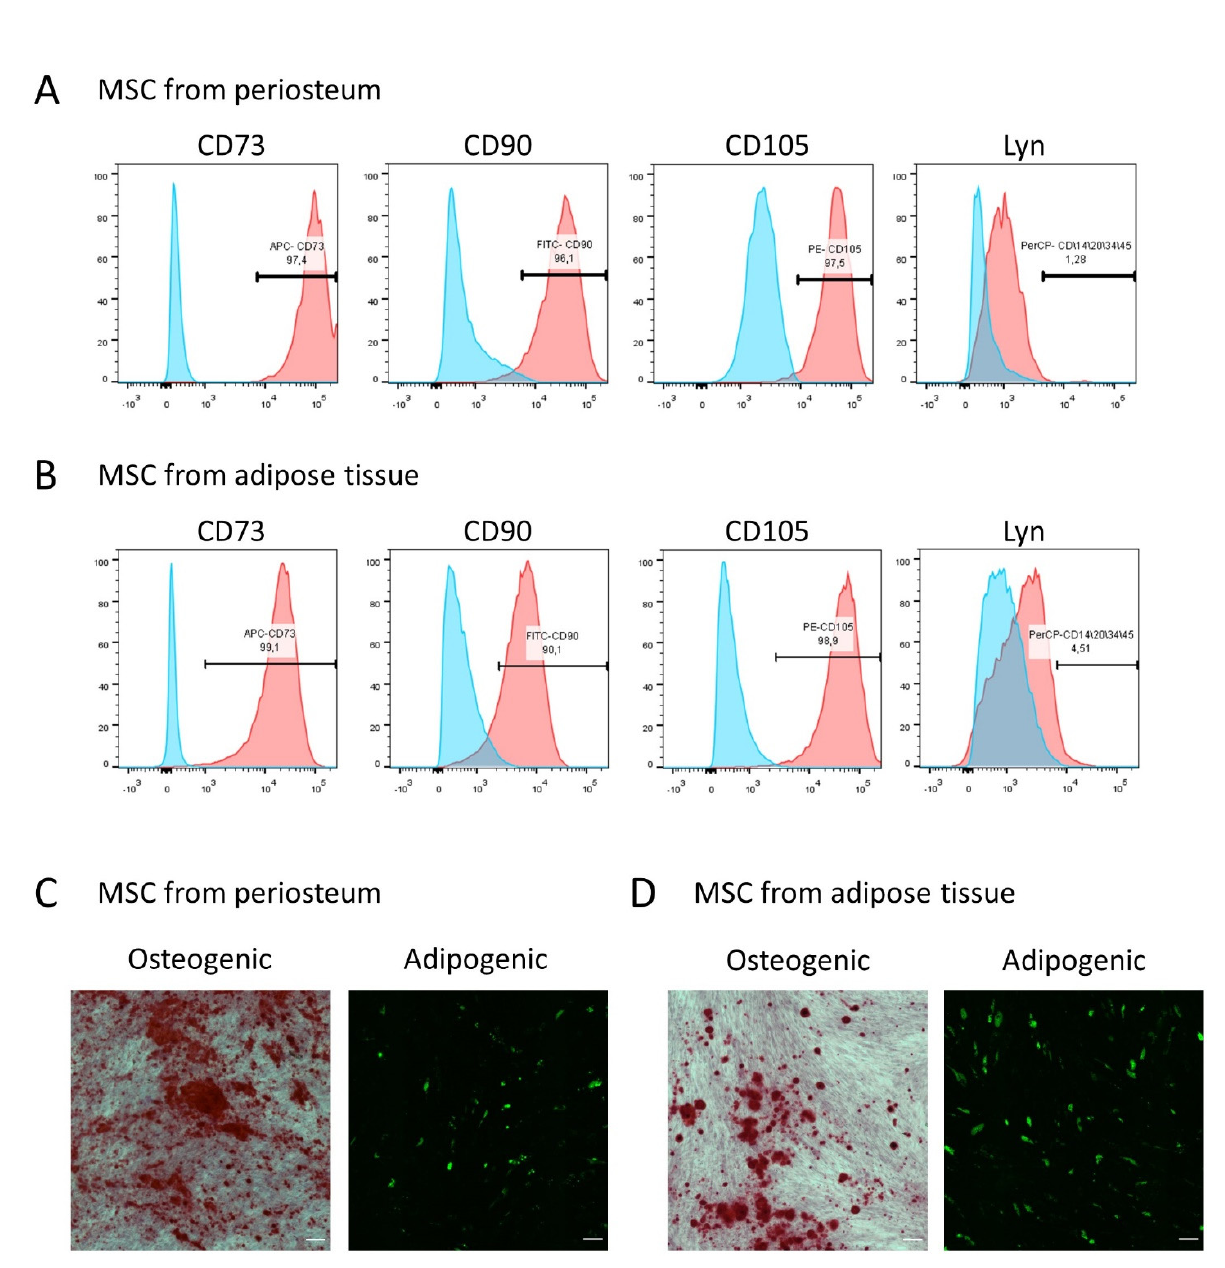
Figure 1. Characterization of MSC isolated from periosteum and adipose tissue. ( A , B ) Flow cytometry analysis of expression of positive surface markers CD73, CD90, and CD105 and negative marker Lyn on MSC from periosteum ( A ) and adipose tissue ( B ). ( C , D ) Differentiation of MSC from periosteum ( C ) and adipose tissue ( D ) into osteogenic (Alizarin red staining) and adipogenic lineage (Nile red staining). The scale bar represents 500 µm.